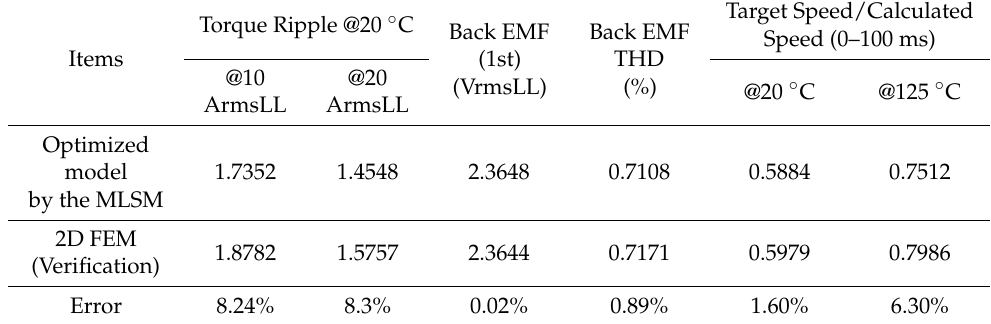
Table 3. Optimal design